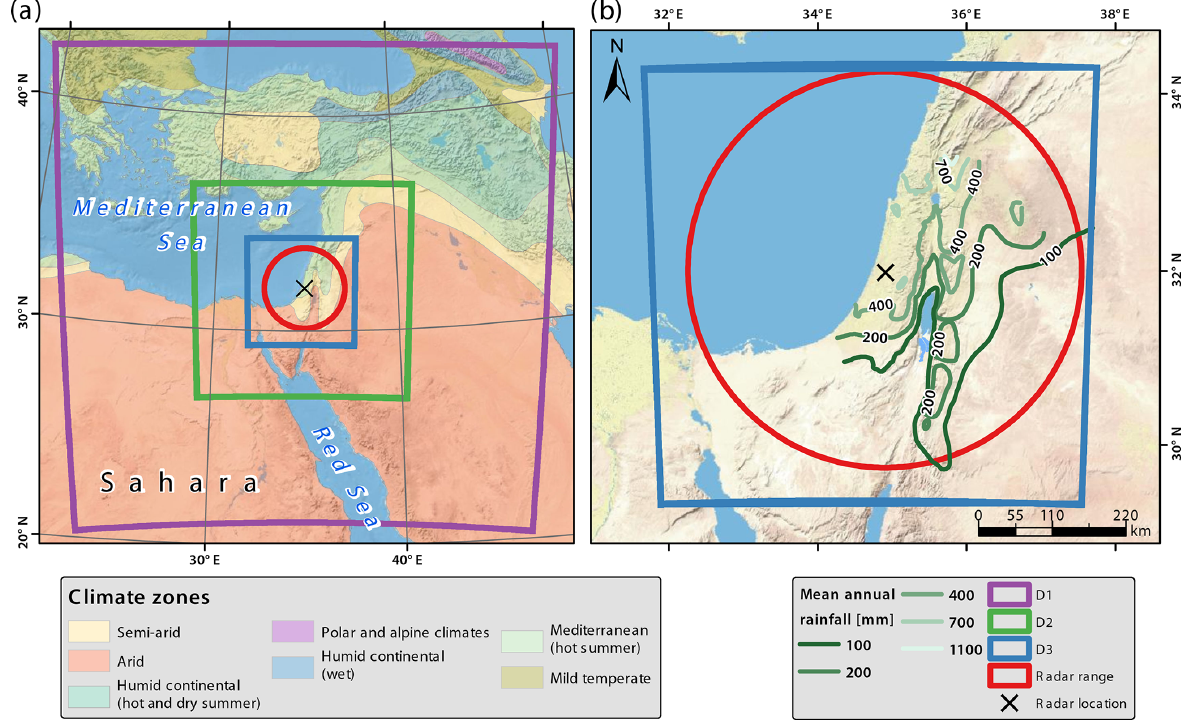
Figure 1. Study region. (a) Climate zones in the eastern Mediterranean, three nested domains used in the weather model (D1-3; purple, green, and blue) and the radar domain (red). (b) Mean annual rainfall isohyets, radar, and innermost model domains. Climatic classification is from the Atlas of Israel (2011). Basemap source: U.S. National Park